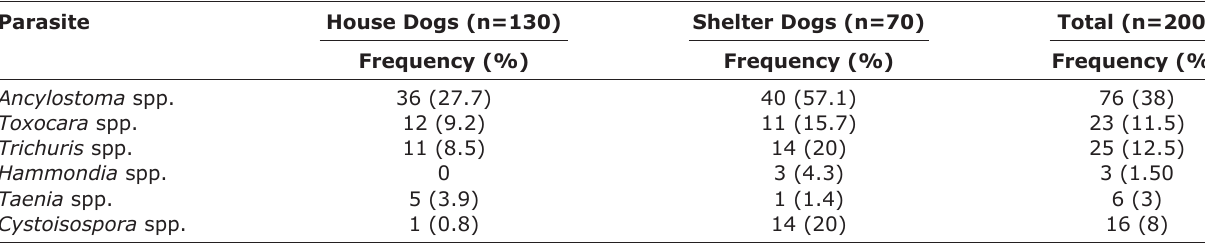
Table-2: GIT parasites detected in Cebu, Philippines (n=200). Parasite